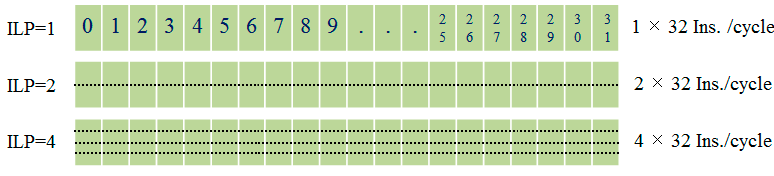
Figure 8. Intra-thread execution order